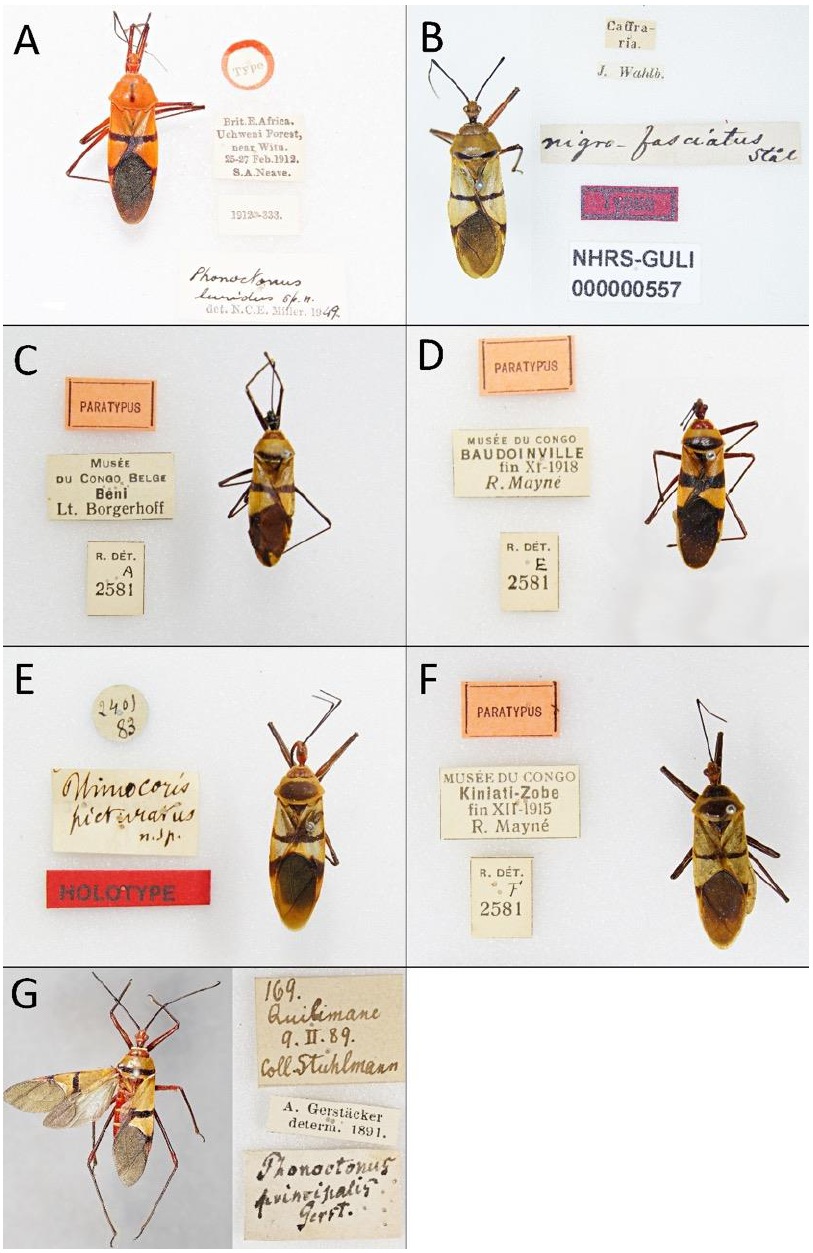
Figure 46. Type specimens of the representatives of Phonoctonus Stål, 1853: ( A ) P. luridus Miller, 1950; ( B ) P. nigrofasciatus Stål, 1855; ( C ) P. fasciatus var. poultoni Villiers, 1953; ( D ) P. picta Schouteden, 1932; ( E ) P. picturatus Fairmaire, 1858; ( F ) P. fasciatus var. discalis Schouteden, 1932; and ( G ) P. principalis Gerstaecker, 1892.